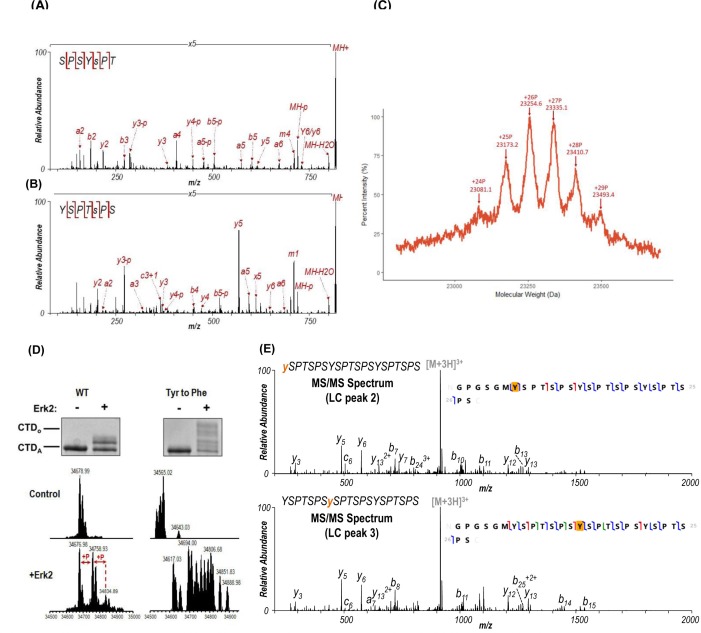
Mass spectrometry analysis of yCTD treated by kinases.(A, B) LC-UVPD-MS/MS MS2 spectra of yCTD treated with P-TEFb: (A) SPSYsPT and (B) YSPTsPS. These spectra correspond to the LC traces in Figure 1A. The locations of the confirmed phosphorylation sites are indicated as lowercase y or s in the sequences. (C) MALDI-TOF of yCTD treated with P-TEFb, zoomed view to show detail. A portion of MALDI-MS spectra of 3C-protease digested yCTD constructs treated with P-TEFb. Mass labels indicate m/z at the various peak maxima. Arrows indicate the maximum and minimum m/z peaks for kinase treatment sample. ‘+#P’ notation indicates an approximate number of phosphates added based on mass shifts relative to no kinase control. (D) EMSA to show the effect of YtoF mutation on CTD gel shift upon kinase phosphorylation. EMSA and intact mass analysis result for Drosophila CTD 9mer before and after treatment with Erk2. (E) LC-UVPD-MS/MS spectra of 3CTD treated with c-Abl. Diagnostic fragmentation of mono-phosphorylated peptides corresponding to LC peaks 2 and 3 from Figure 2B are shown in the top and bottom spectra, respectively.